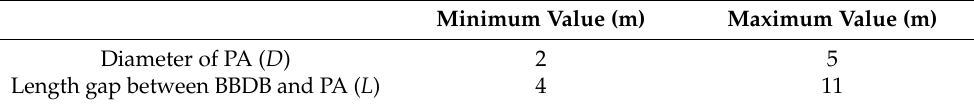
Table 1. Minimum and Maximum values for the Hybrid BBDB-PA Condition Parameter.